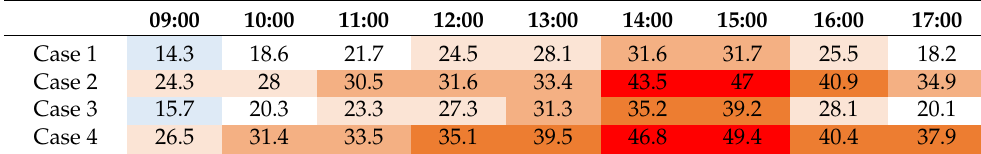
Table 6. Average PET changes in